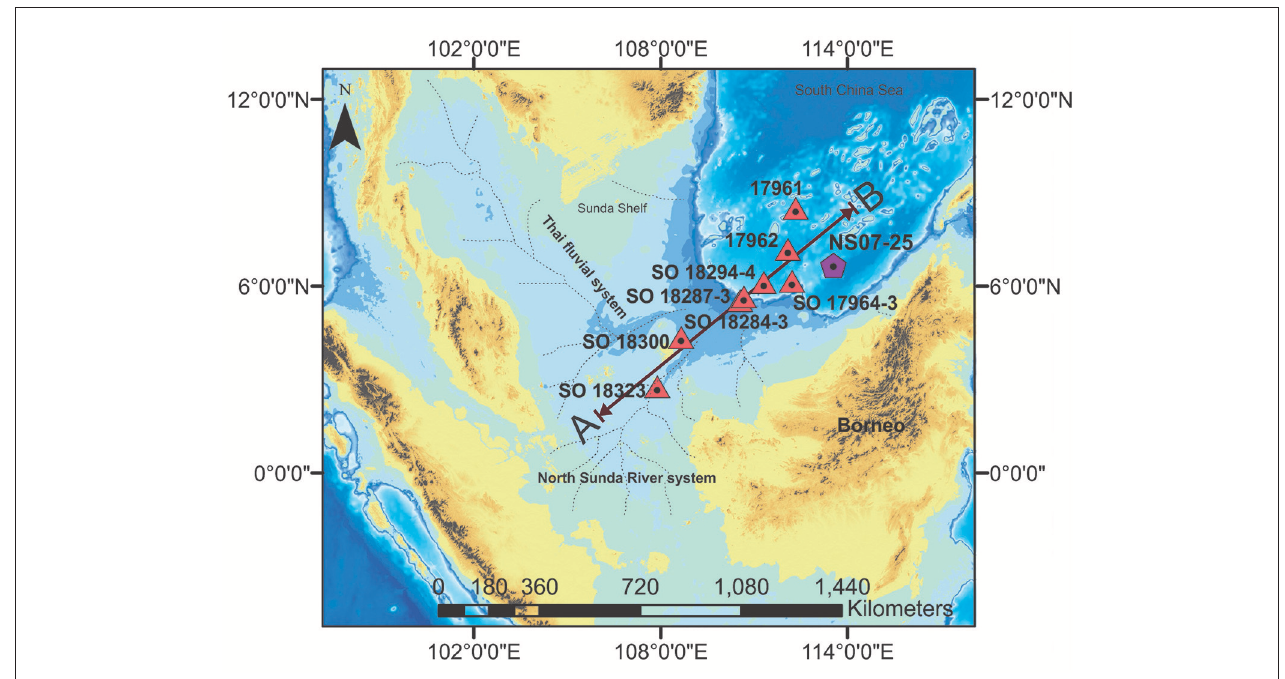
FIGURE 1 | Map of the southern South China Sea showing the location of deep ocean sediment core (NS07 25) location and the other sediment core locations which are used in this paper. Major Paleo-rivers flows in to the southern South China Sea are marked according to Voris (2000). Sediment cores have been selected from the continental shelf, the continental slope and from the Deep Ocean (red triangle). Sediment cores alignments were chosen between the NS07-25 and two major paleo rivers (namely, the Saim River system and the North Sunda River system). Toward A to B direction, the water depth and the distance from the Sunda Shelf